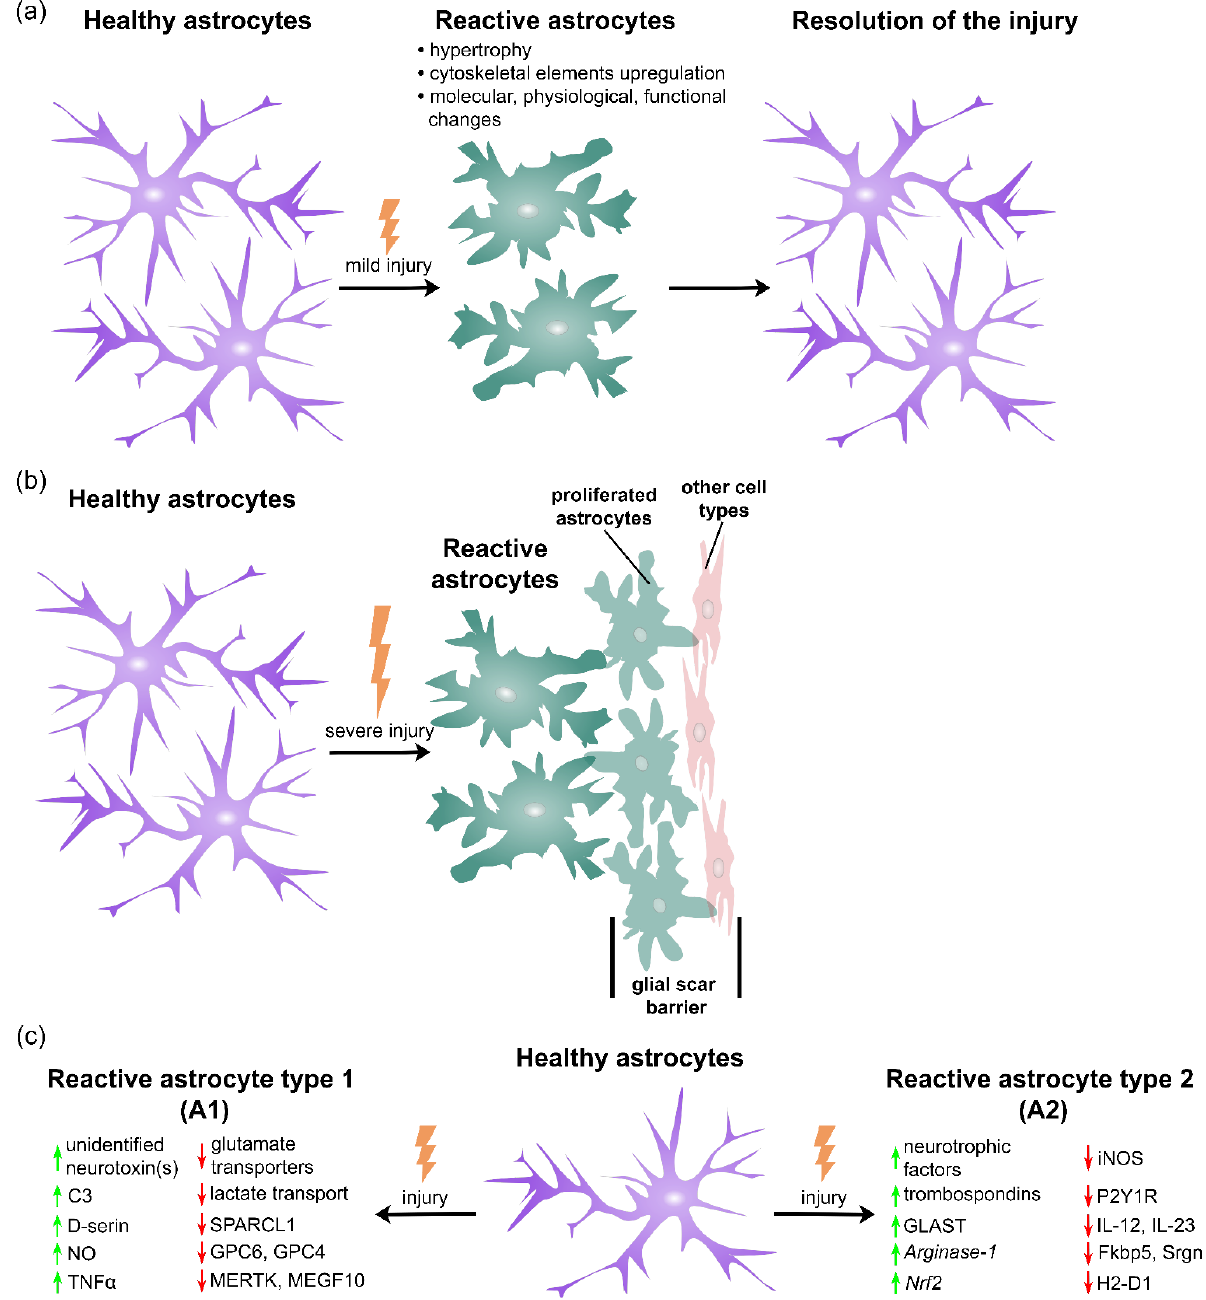
Figure 2. Types of reactive astrocytes. Based on the severity of the CNS injury, reactive astrocytes can be classified into two main subtypes: hypertrophic, and scar-forming reactive astrocytes. ( a ) As a result of mild CNS injuries (mild trauma, viral or bacterial infections) astrocytes become hypertrophic and go through variable levels of molecular, functional, and physiological changes. During mild injury, astrocytes do not proliferate, stay in their original positions, and they keep interacting with the same type of cells as in healthy CNSs. In this type of reactive astrogliosis, resolution of the injury is possible and there is no permanent tissue rearrangement. ( b ) As a result of severe injury,